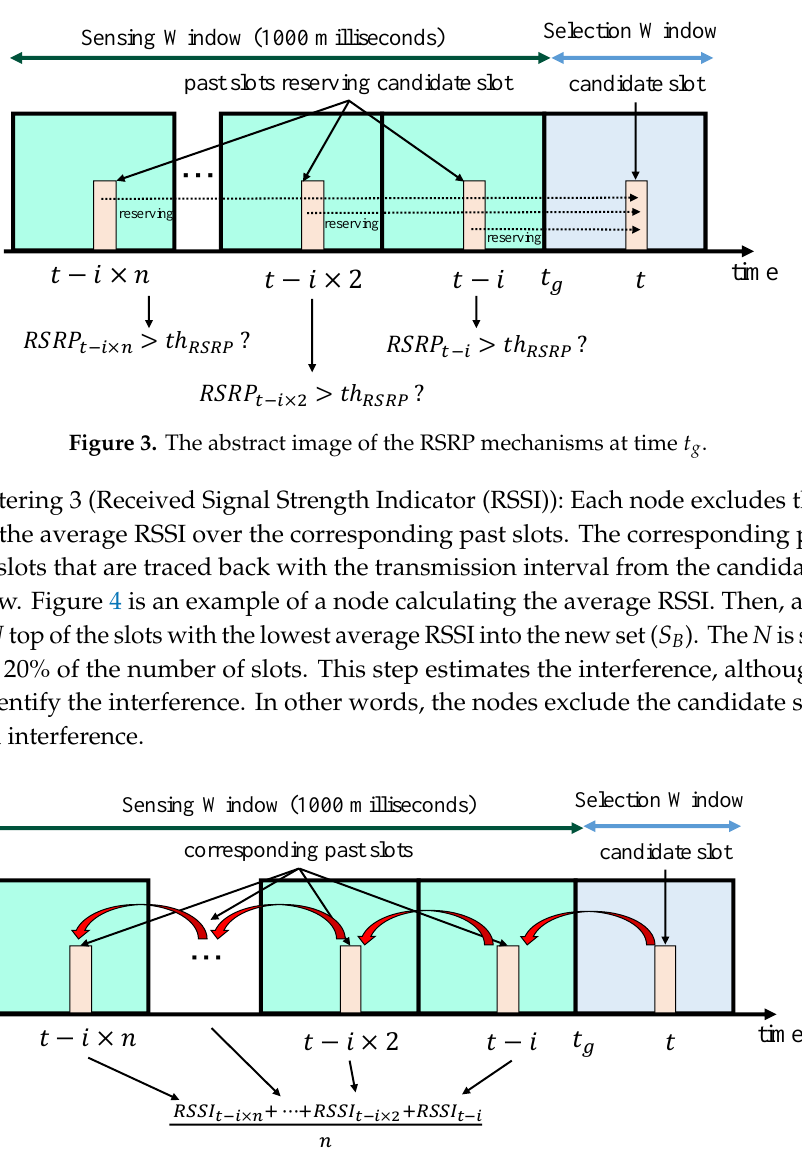
Figure 4. The abstract image of the RSSI mechanism at time 𝑡 𝑔 .